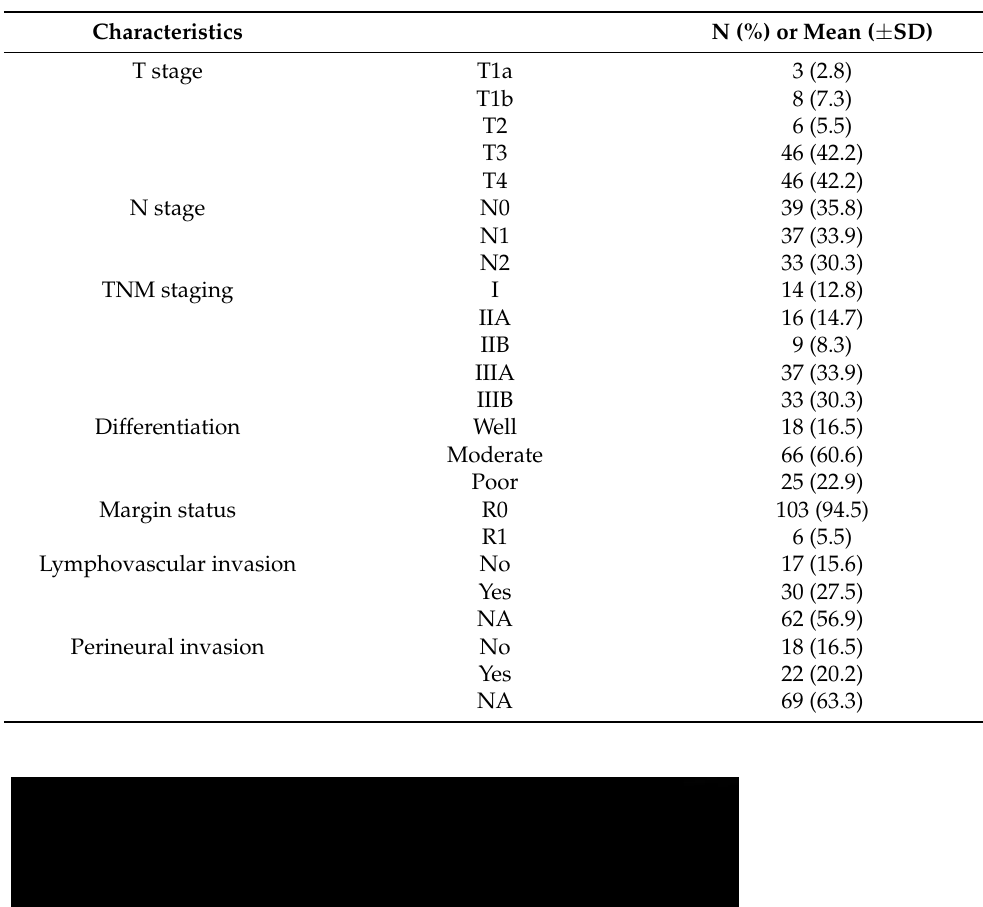
Table 2. Pathological characteristics ( n = 109).